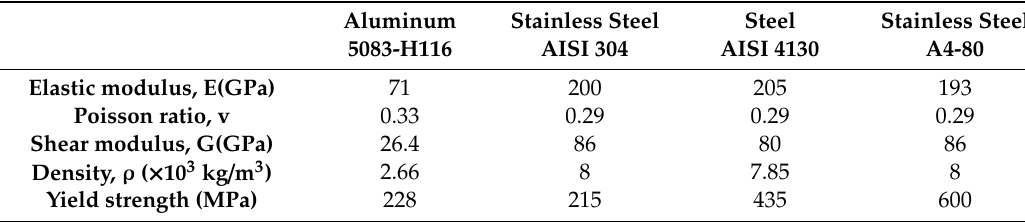
Table 5. Materials properties used in the final modelling.